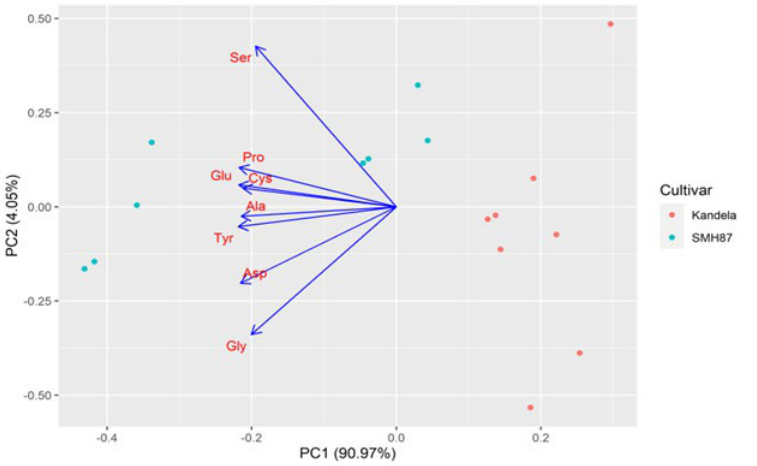
Figure 5. Biplot of principal component analysis for endogenous amino acid assessment results. Ser (serine), Asp (asparagine), Glu (glutamine), Pro (proline), Gly (glysine), Ala (alanine), Tyr (tyrosine), Cys (cysteine).